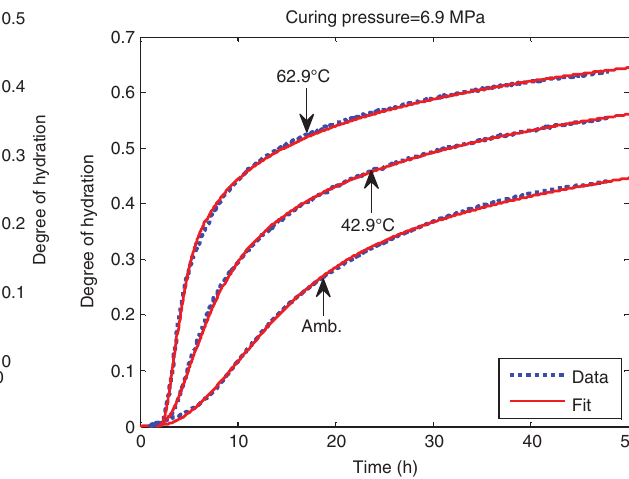
Figure 4: Representative model fit to experimental data of Class H cement cured at different temperatures (w/c =